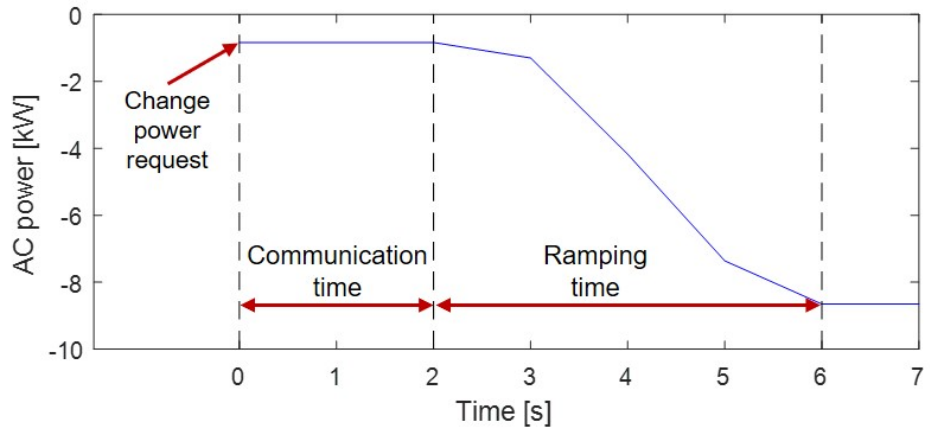
Figure 5. Example of a request for changing the power output from -1 to -10 kW (discharge mode). The V2G system takes 6 s to implement the order (total response time), taking 2 s to receive the order (communication time) and 4 s to effectively change the power output (ramping time).